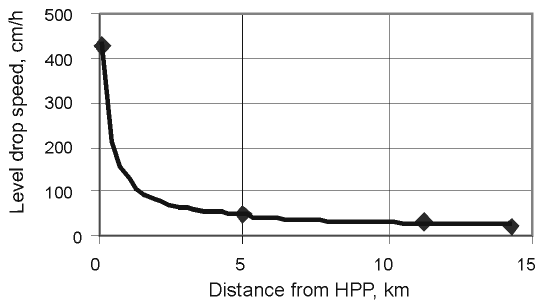
Fig. 4. Graph of stage drop speed versus distance from Kaunas